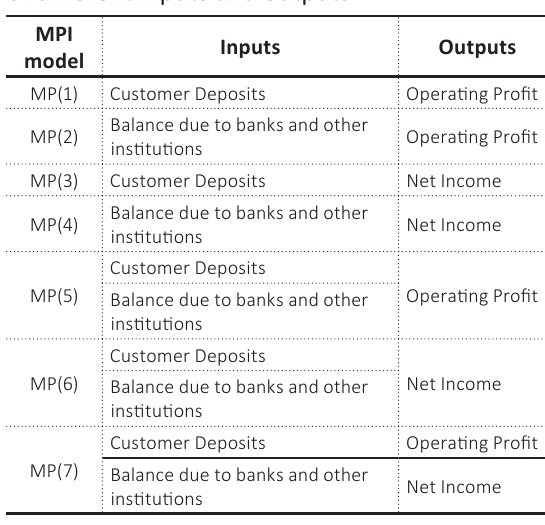
Table 4. MPI models with a combination of different inputs and outputs